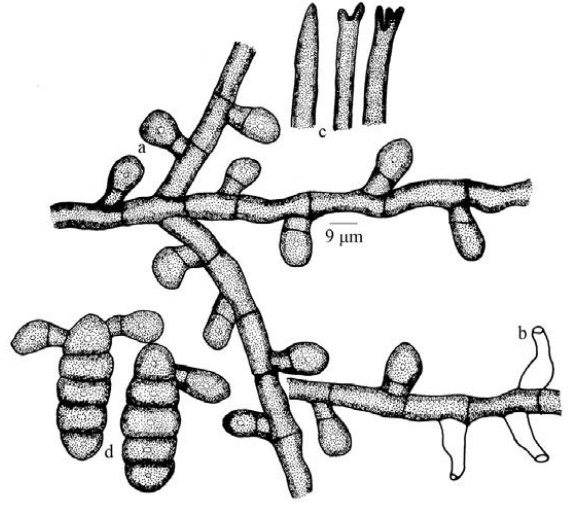
Figure 10. Meliola chukrasiicola sp. nov. a - Appressorium, b - Phialide, c - Apical portion of the mycelial setae; d -